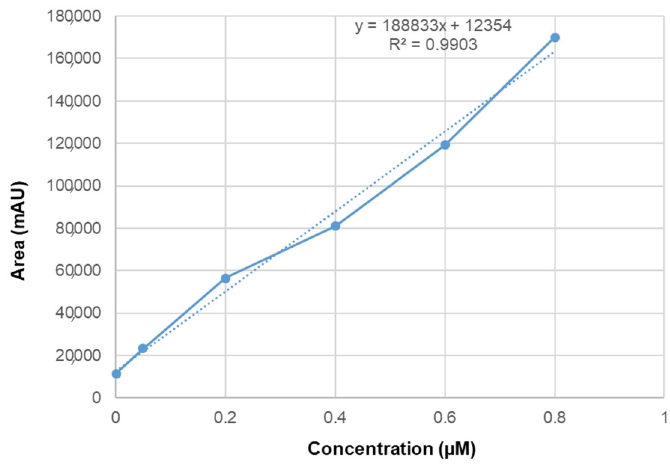
Figure 1. Analytical curve of the HPLC-TBARS-EVSC assay in the range of 0.001 to 0.8 µM, with line equation y = 188,833x + 12,354.